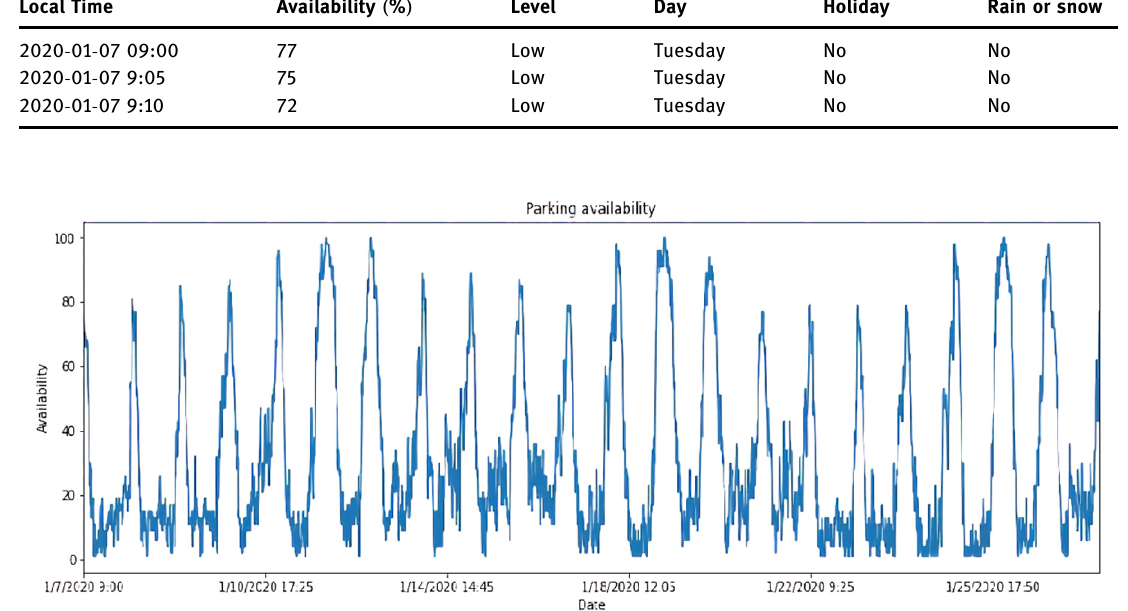
Figure 2: Illustration of the parking availability of the total dataset.